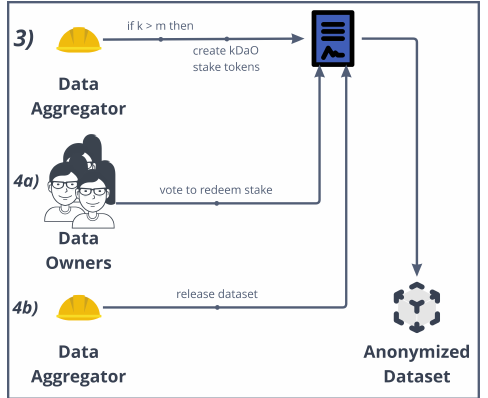
Figure 7. Example of the anonymized dataset creation and DAO